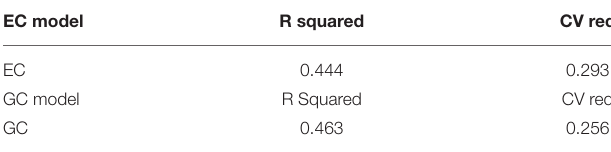
TABLE 11 | Effect size index of occupant behaviour effect on energy